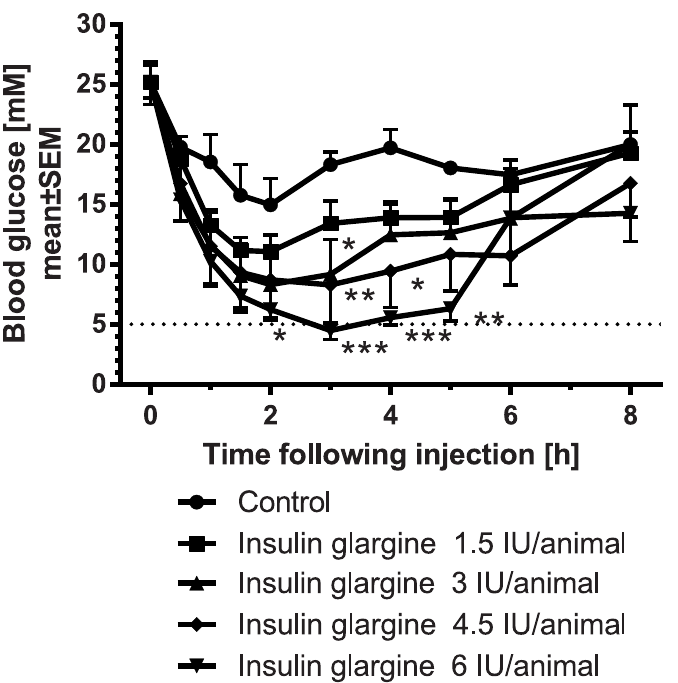
Fig 1. Dose-response curve of insulin glargine (1.5, 3, 4.5, 6 IU/animal) in STZ-diabetic rats over 8 h; normoglycemia is indicated by the dotted line. * p < 0.05, ** p < 0.01, *** p < 0.001 vs. control.